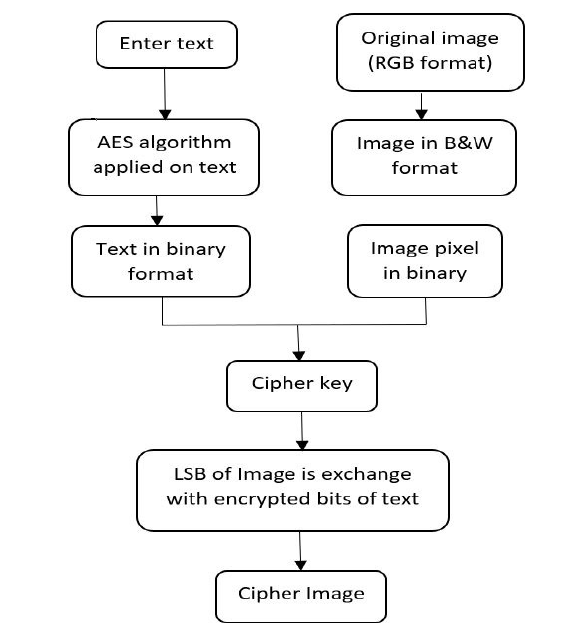
Figure 4. ENCRYPTION